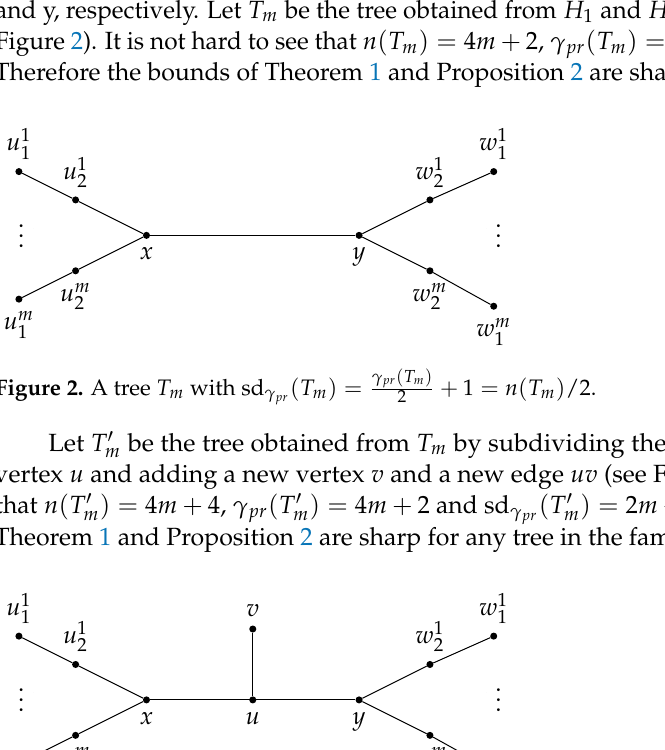
(cid:48) + 1 = n ( T (cid:48) m ) 2